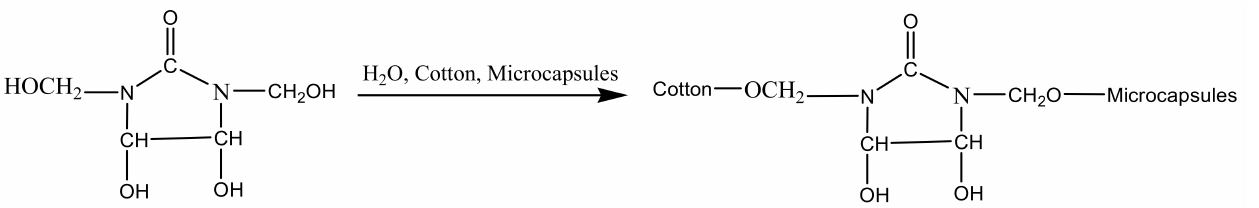
Figure 6. Chemical reaction between DMDHEU resin and Cotton/Microcapsules.